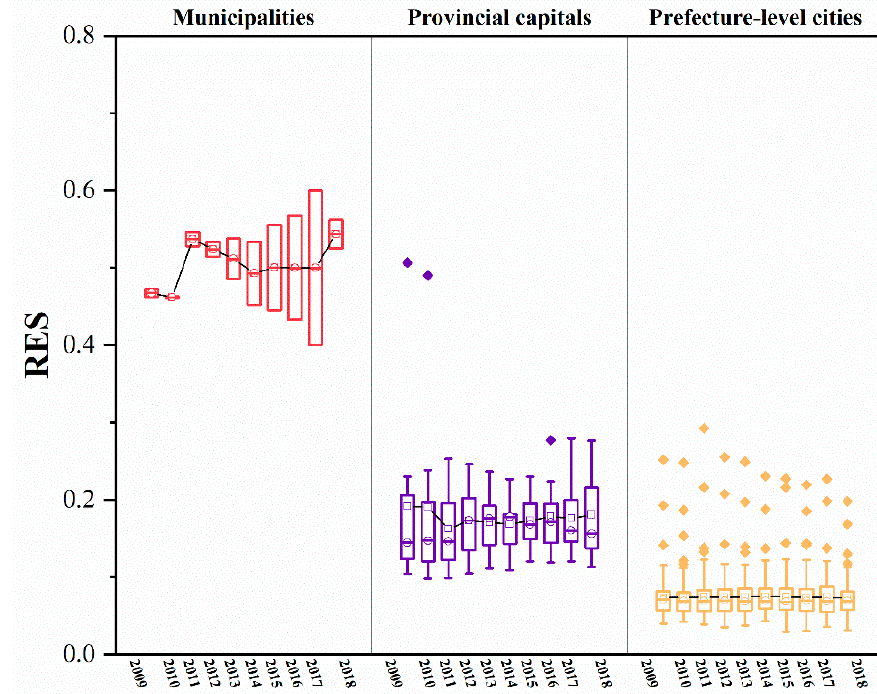
Figure 5. RES index of cities at different administrative levels in 2009 and 2018.